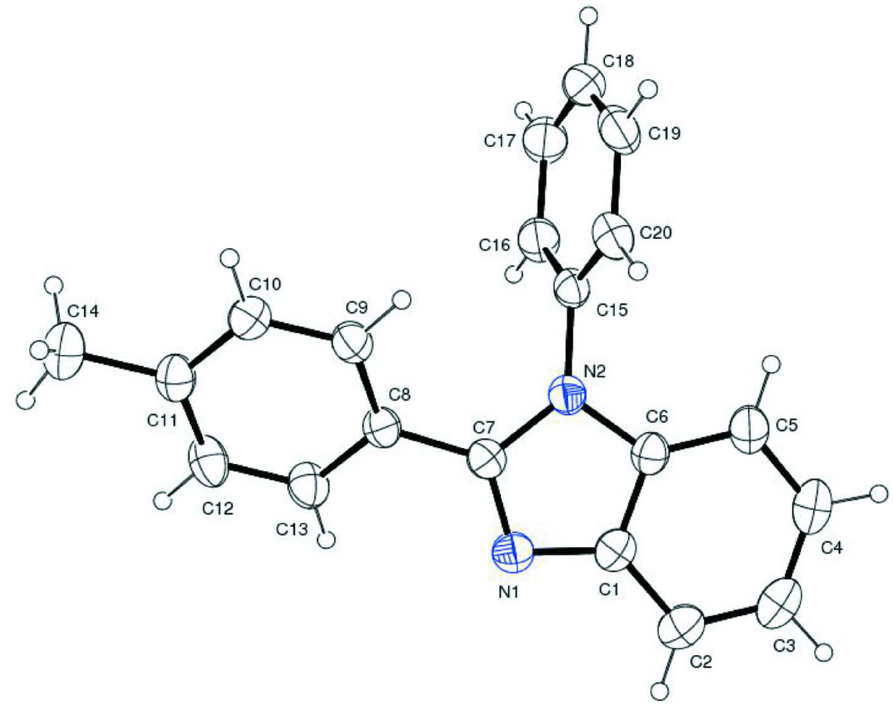
The molecular structure and labelling scheme for (I) with displacement ellipsoids for non-H atoms drawn at the 30% probability